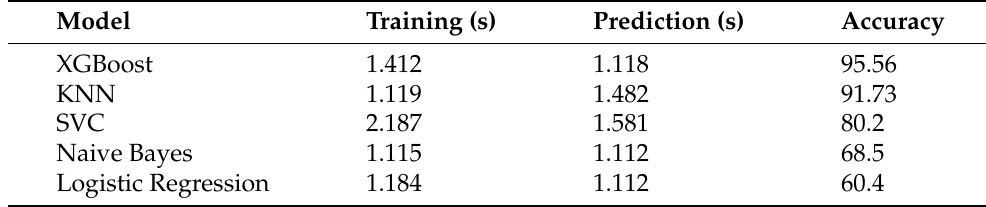
Figure 14. Cross validation of the test recall results. Table 4. Comparison results of machine learning